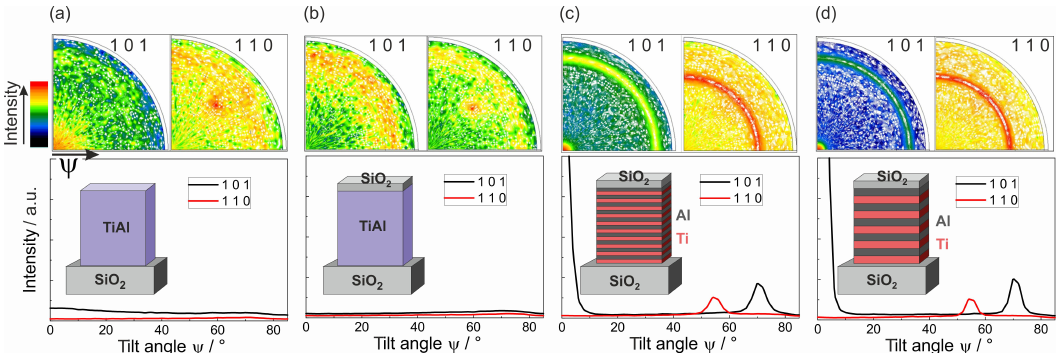
Figure 2. Results of the texture measurements of: ( a ) a co-sputtered Ti-Al film; ( b ) a co-sputtered Ti-Al film with SiO 2 cover layer; ( c ) a ML Ti/Al film with 10 nm individual layer thickness; and ( d ) a ML Ti/Al film with 20 nm individual layer thickness, both with SiO 2 cover layer, after annealing at 600 ◦ C. The graphs represent the azimuthally averaged intensity versus the tilt angle Ψ